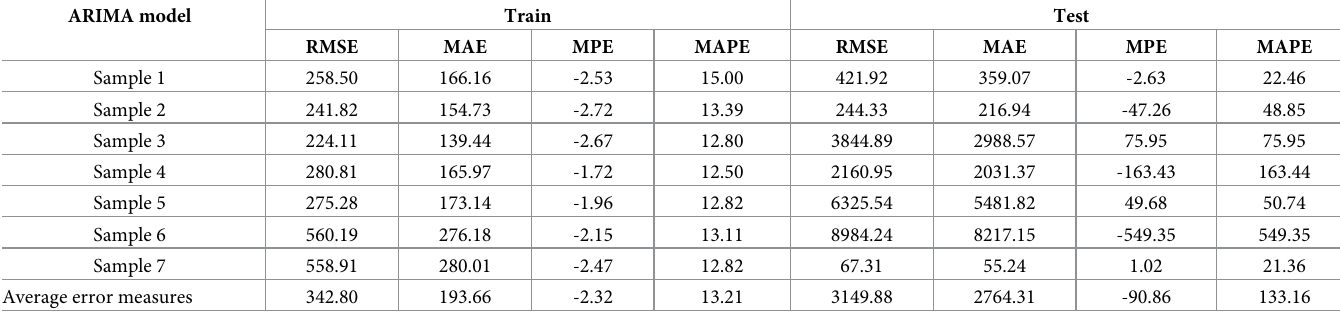
Table 2. Evaluation of parameters for the ARIMA model of different training and test sets for COVID-19 confirmed cases. ARIMA model